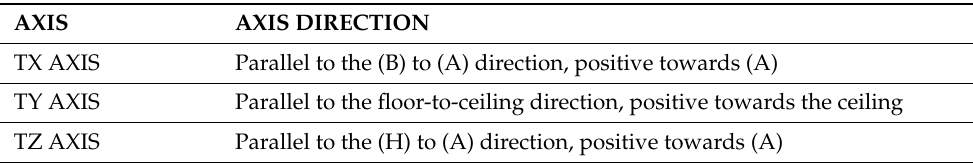
Table 2. Direction of V120:TRIO axes (for positions) with respect to labels (H), (A), and (B). AXIS AXIS DIRECTION TX AXIS Parallel to the (B) to (A) direction, positive towards (A) TY AXIS Parallel to the floor-to-ceiling direction, positive towards the ceiling TZ AXIS Parallel to the (H) to (A) direction, positive towards